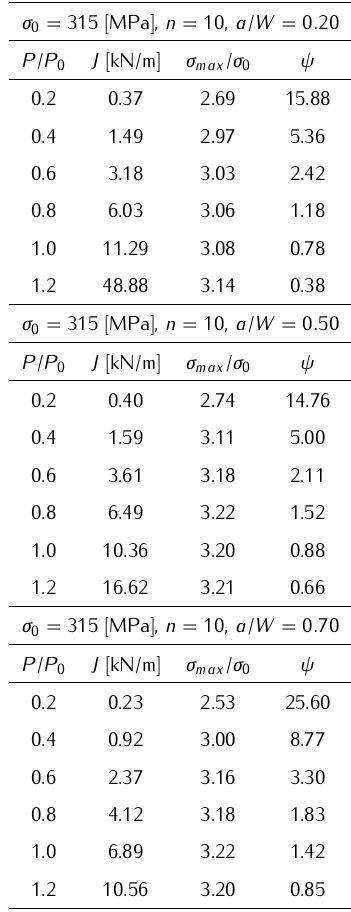
Table A4. Numerical results for CC(T) specimens characterized by yield stress σ MPa and work hardening exponent 0 = 315 in R-O relationship n =